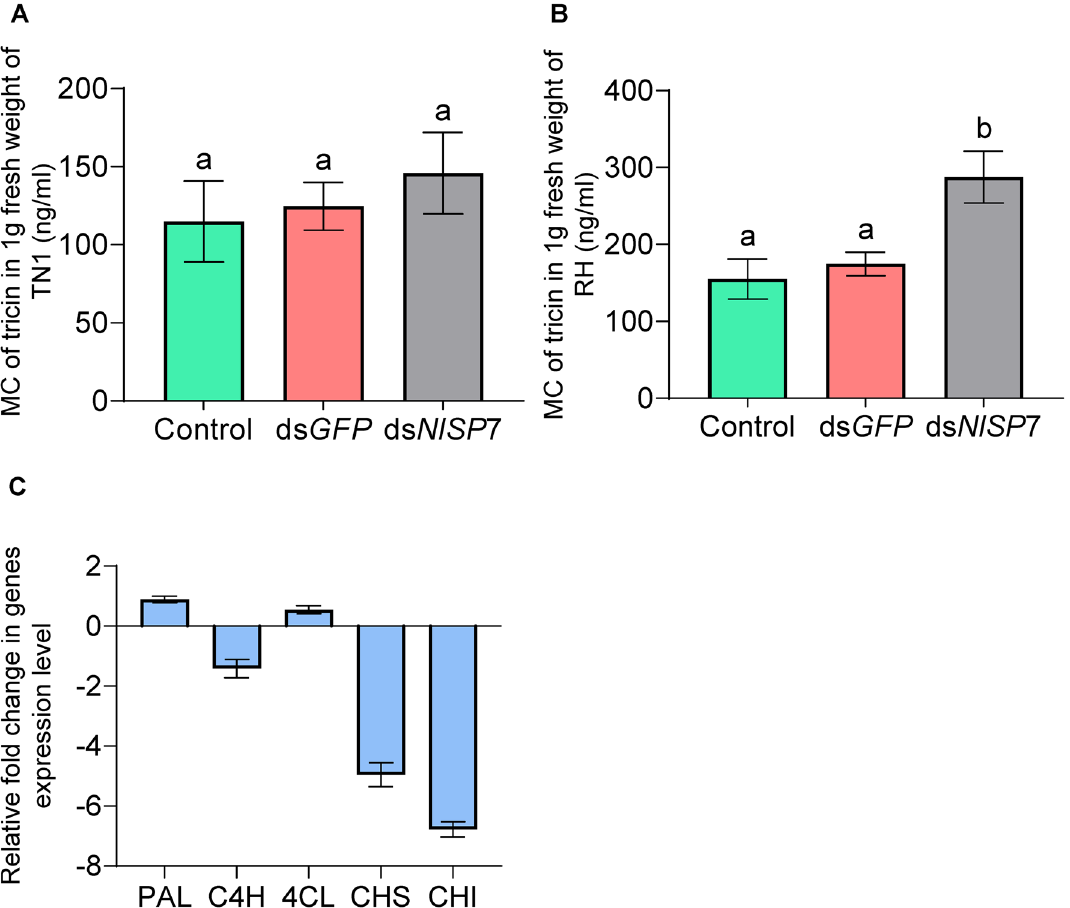
Figure 7. The effect of brown planthoppers in three groups (control, injected with ds GFP , injected with ds NlSP7 ) on the tricin content and tricin metabolic pathway genes of different rice varieties. ( A ) Taichung Native 1 (TN1) and ( B ) Rathu Heenati (RH) rice varieties fed on by brown planthoppers. After 3 days, the content of tricin was determined by liquid chromatography-mass spectrometry, A same letters above the bars indicate no significant differences between three treatment groups, and B different letters above the bars indicate significant differences between BPHs injected with ds NlSP7 and two control groups (control and ds GFP ). Data are represented as the mean ± SD from three biological replicates ( P < 0.01, Duncan’s multiple range test). ( C ) The q-PCR used to determine the expression level of tricin metabolic pathway genes (PAL, C4H, 4CL, CHS, CHI) in rice after being fed on by brown planthoppers. The experiment was repeated three